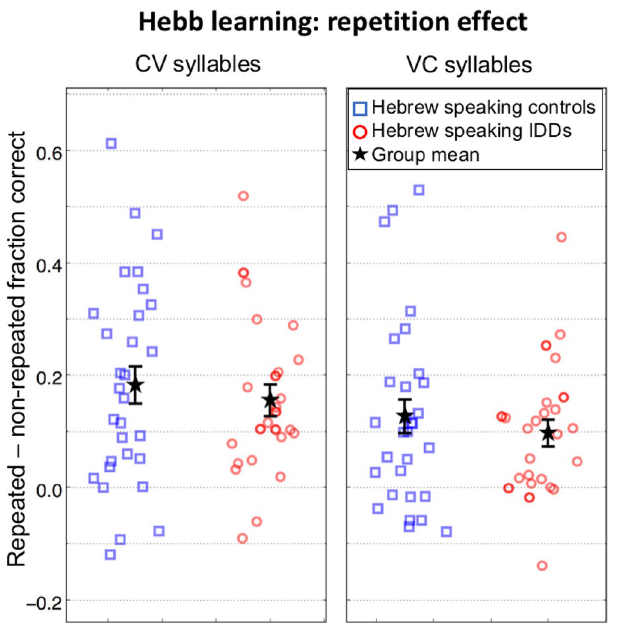
Figure 3. Difference between scores for repeated (Hebb) vs. non-repeated (filler) sequences of CV (left) and VC (right) syllables. The benefit is larger for CV syllables and is similar for controls (blue squares) and IDDs (red circles). Symbols denote individual difference scores. Error bars denote one SEM. The values are slightly jittered for display